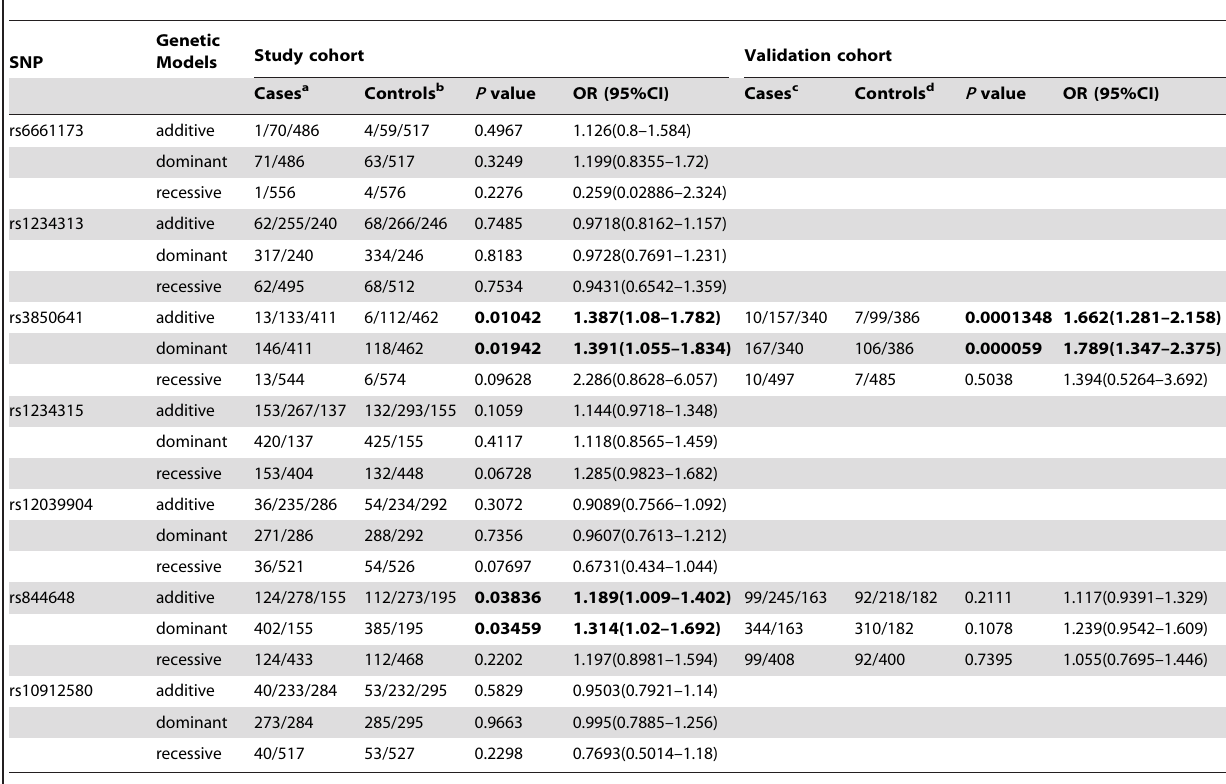
Table 3. Genotyping and genetic models of OX40L gene SNPs in cases and